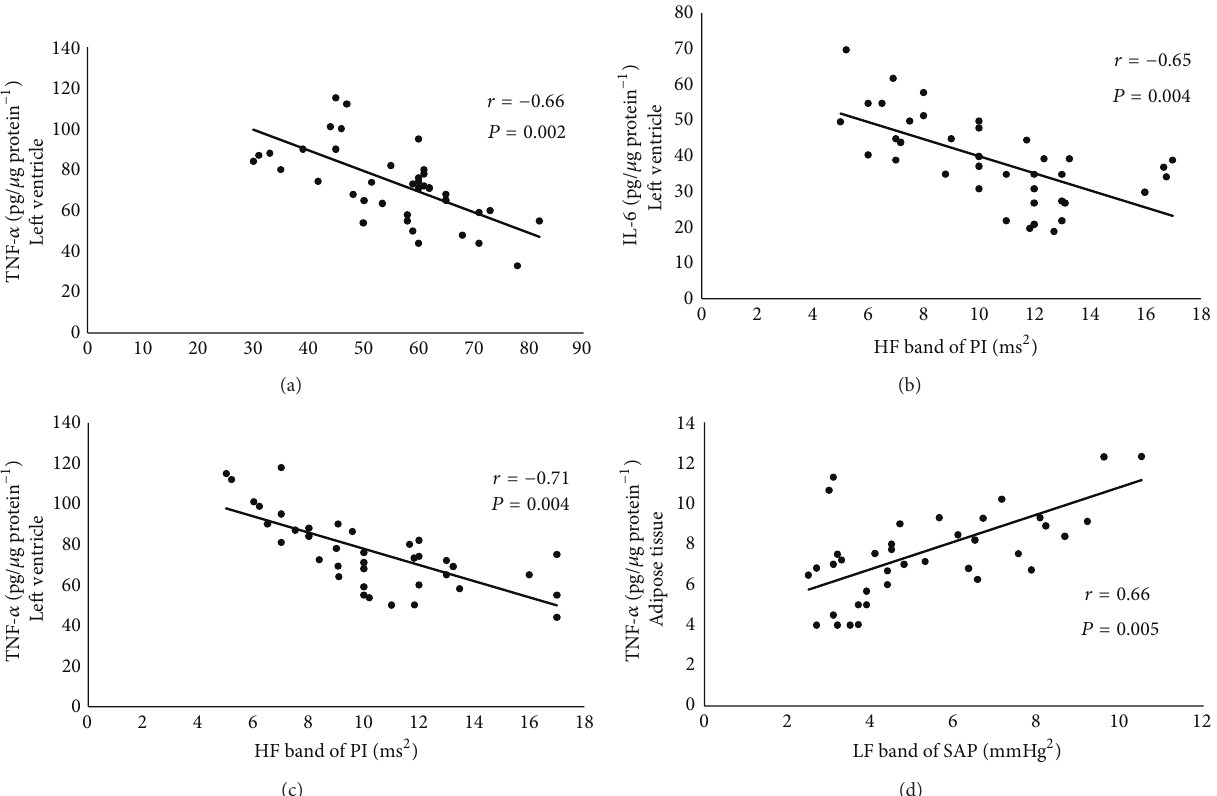
Figure 6: Correlations between (a) ejection fraction (EF) and TNF- 𝛼 levels in the LV. (b) High frequency band of pulse interval variability (HF band) and IL-6 levels in the LV. (c) High frequency band of pulse interval variability (HF band) and TNF- 𝛼 levels in the LV. (d) Low frequency band of systolic arterial pressure variability (LF band) and TNF- 𝛼 levels in the adipose